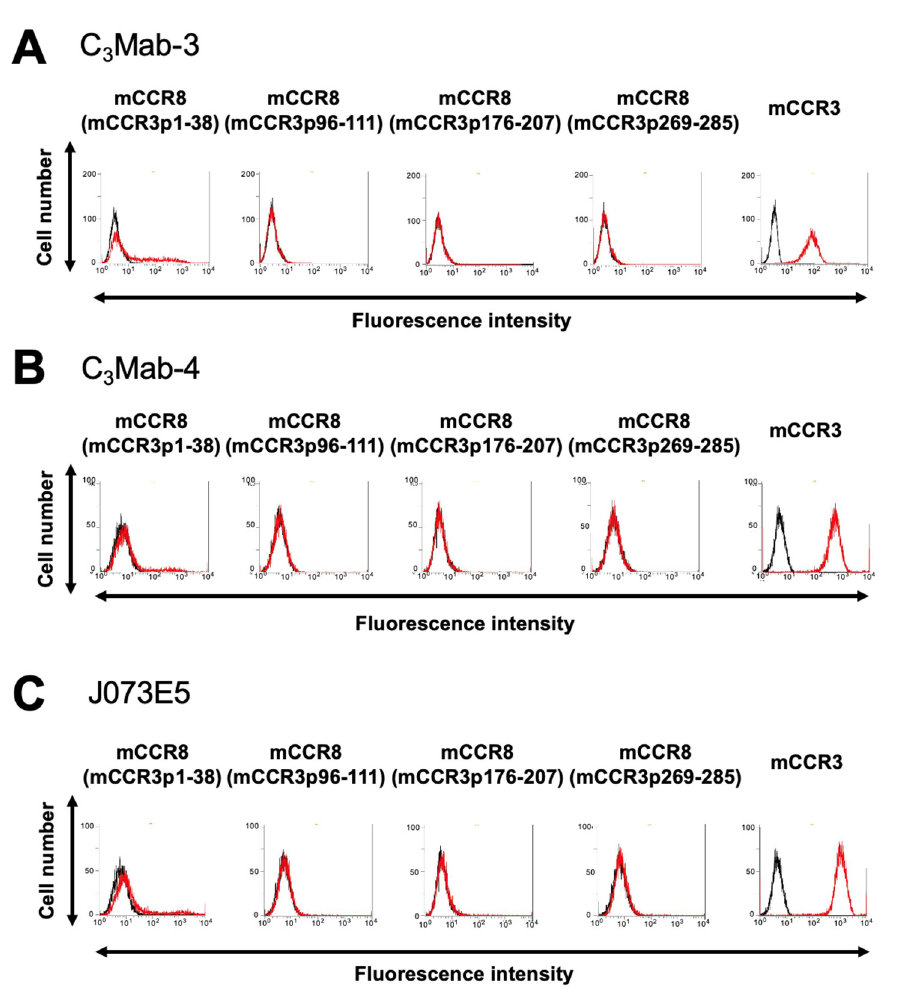
Figure 2. Determination of the epitope of anti-mCCR3 mAbs using flow cytometry and chimeric proteins. C 3 Mab-3 (1 μg/mL) ( A ), C 3 Mab-4 (1 μg/mL) ( B ), and J073E5 (1 μg/mL) ( C ) were treated with CHO-K1 cells that transiently expressed chimeric proteins for 30 min at 4 °C, followed by the addition of Alexa 488-conjugated anti-rat IgG. Red lines show the cells with anti-mCCR3 mAbs treatment, and black lines show cells without anti-mCCR3 mAbs treatment as a negative control.